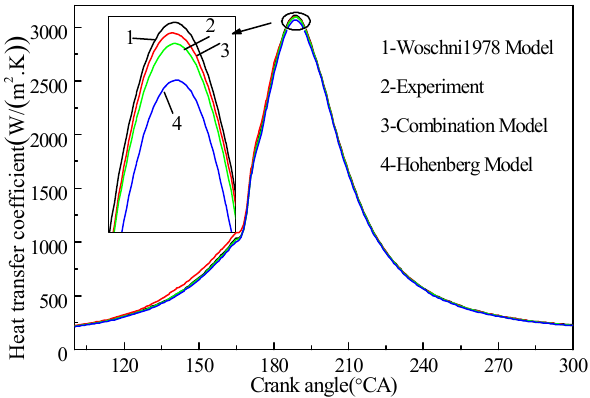
Figure 3. Heat transfer coefficient.